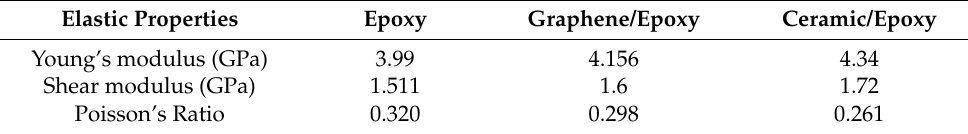
Table 2. Elastic properties of epoxy and Nanocomposites.